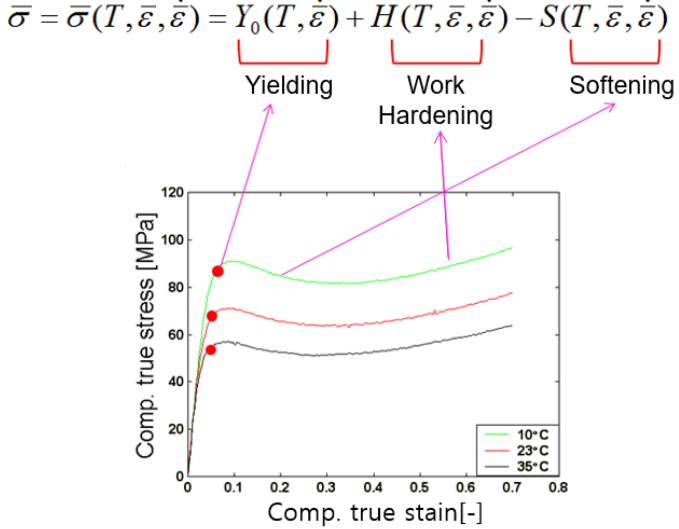
Figure 1. Stress-strain relation of poly methyl methacrylate (PMMA) in the low temperature re- gion